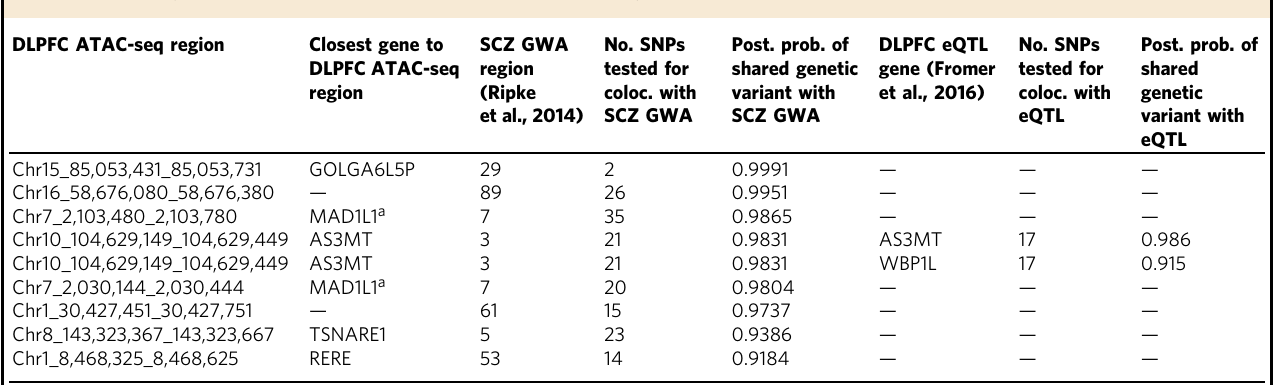
Table 2 Summary of colocalization of cQTL variants with schizophrenia GWA and eQTLs